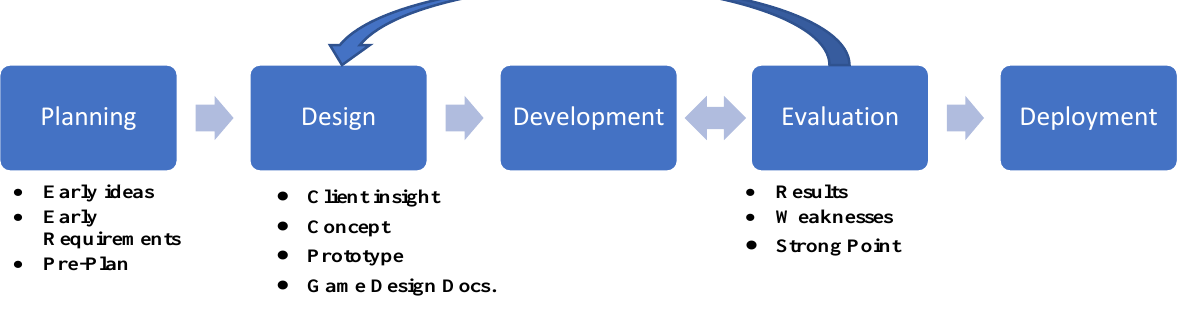
Figure 2 . This is a legend. Caption to go below